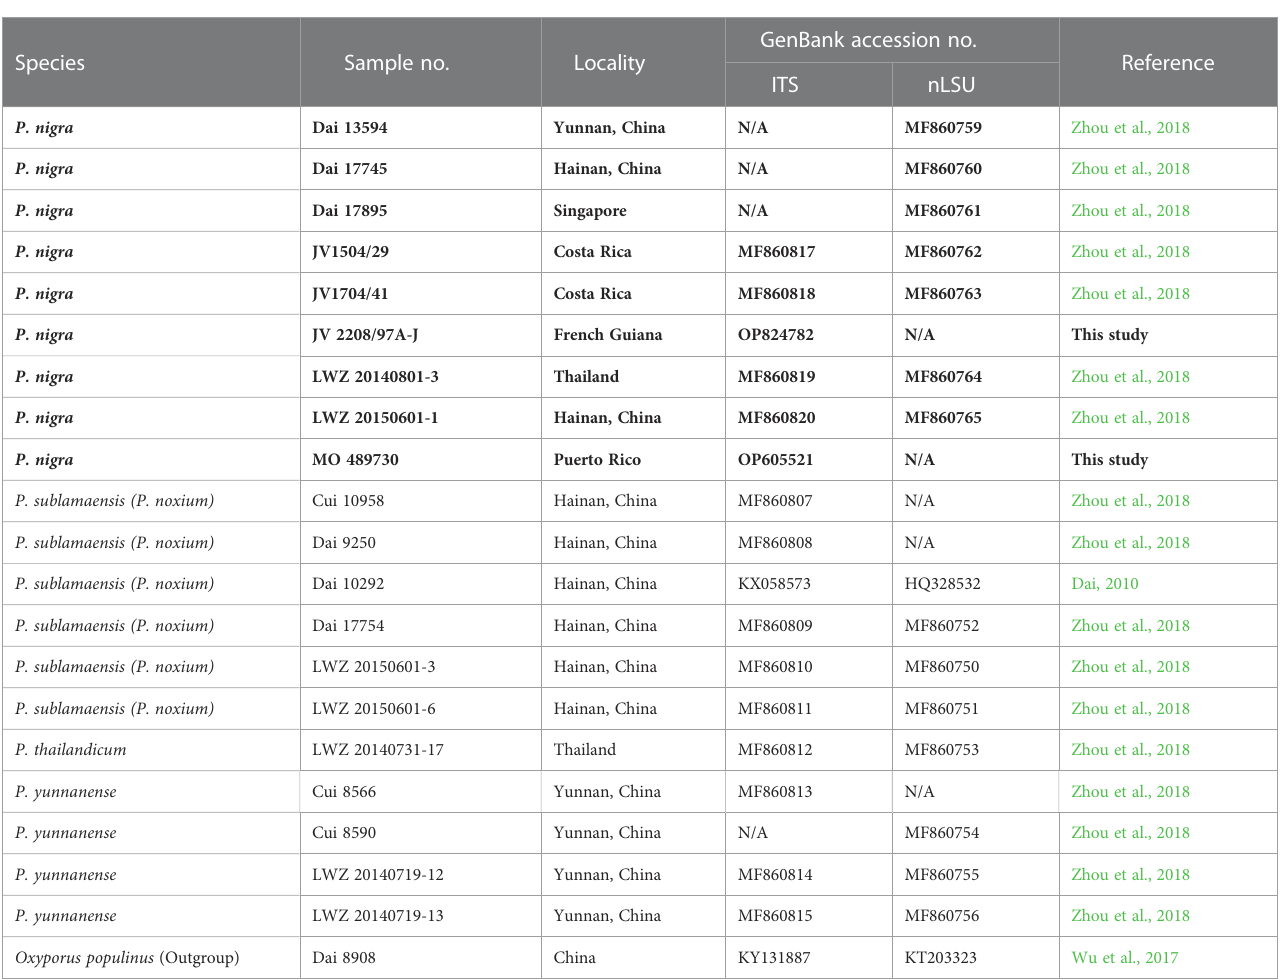
a 50% majority consensus tree and for calculating Bayesian posterior probabilities